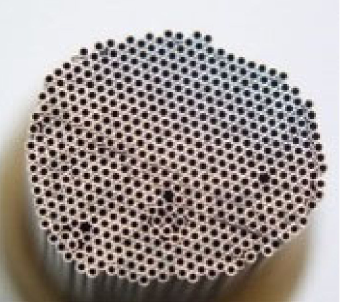
Figure 2. Image of a bundle of 500 hypotubes.